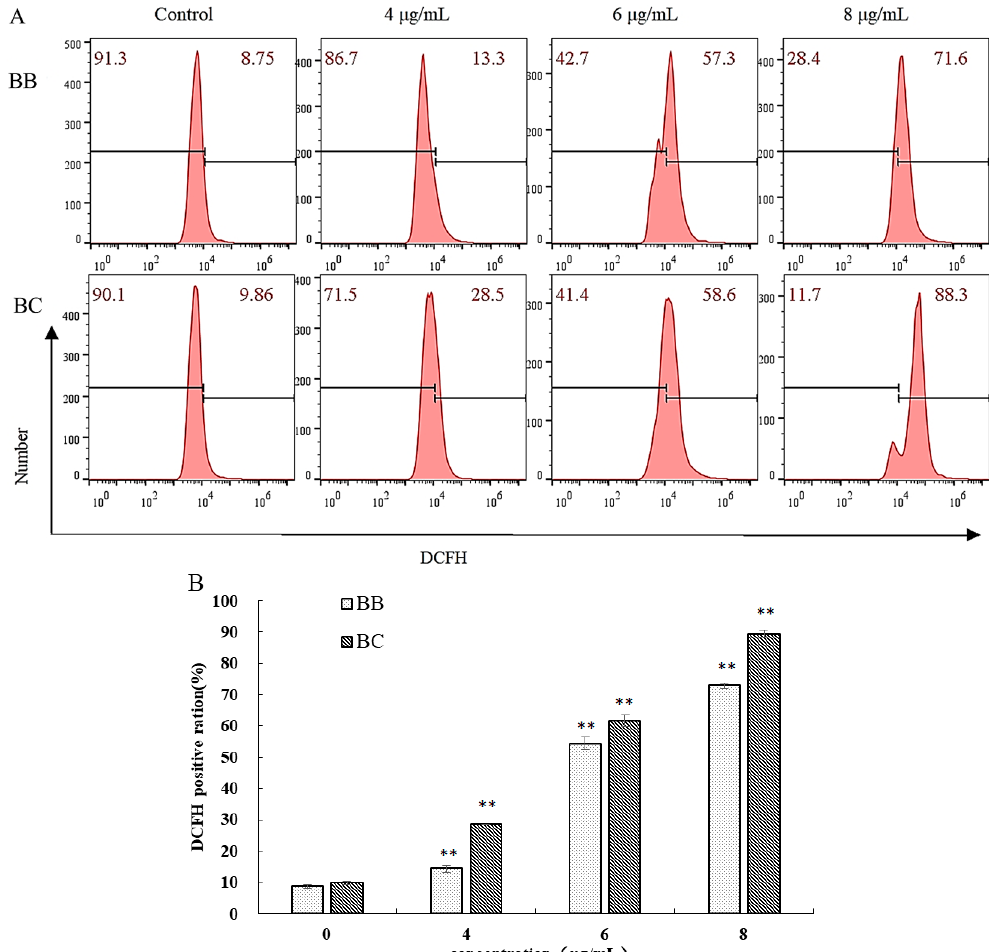
Figure 7. Effect of BB and BC on the ROS levels of BGC-823 cells (( A ) DCFH-DA monochrome flow chart; ( B ) DCFH positive proportion statistical chart; ** p < 0.01).